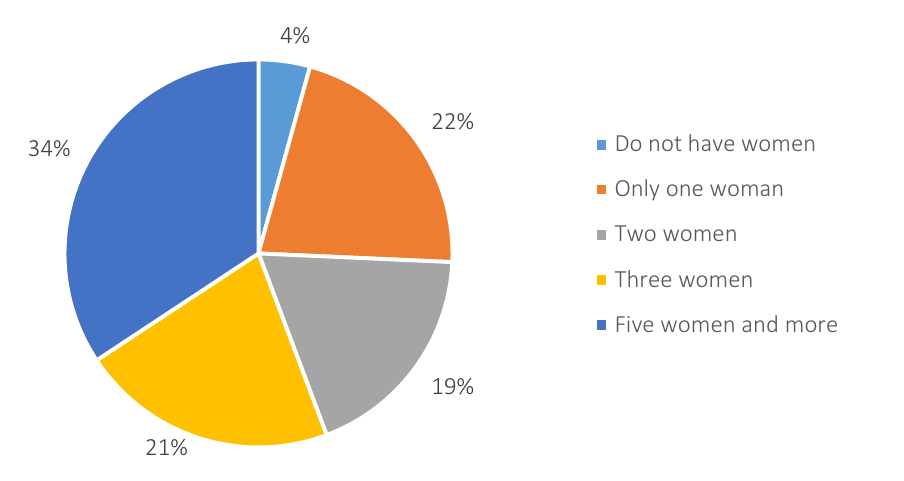
Figure 1. Distribution of percentage share of women in the companies